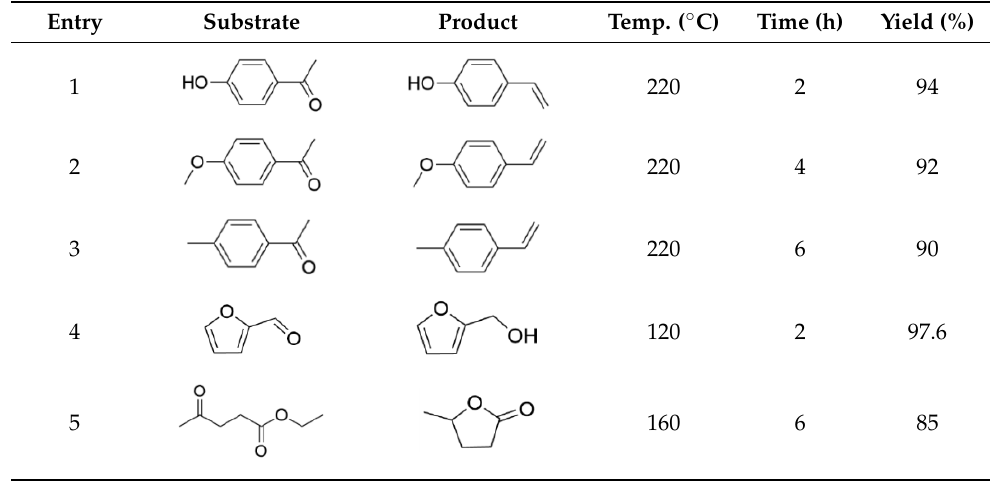
Scheme 2. Possible reaction pathways for conversion of 4-MOPP to AN catalyzed by PhP-Hf